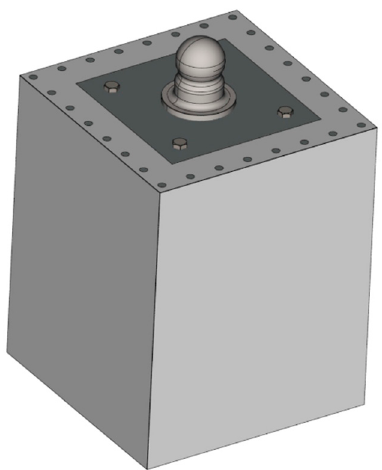
Figure 8. CAD of the column support connection with steel-reinforced concrete.